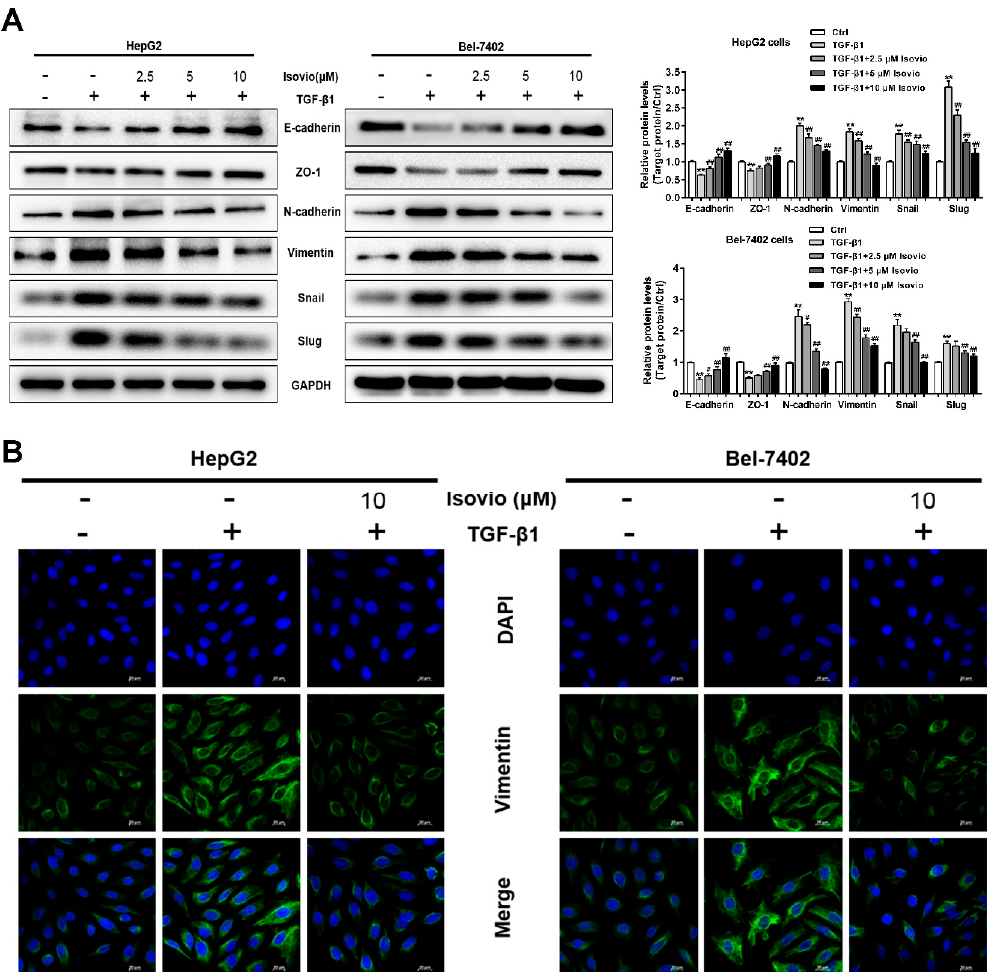
Figure 5. Effects of isoviolanthin on TGF- β 1-induced epithelial–mesenchymal transition (EMT) in HCC cells. ( A ) HepG2 and Bel-7402 cells were treated with 10 ng/mL TGF- β 1 for 48 h, during which the indicated concentrations of isoviolanthin were added for the last 24 h. The expression of the EMT markers E-cadherin, ZO-1, N-cadherin, vimentin, Snail, and Slug was assessed by Western blotting. GAPDH was used as a loading control. ( B ) E-cadherin and vimentin expression in HCC cells was determined by confocal microscopy. Green fluorescence indicates E-cadherin- and vimentin-positive expression, and blue fluorescence indicates 4’,6-diamidino-2-phenylindole (DAPI)-labeled nuclei. Scale bars: 20 µm. Representative images and bar graphs (mean ± SD) are shown, n = 3. ** p < 0.01 versus the control group; # p < 0.05, ## p < 0.01 versus the TGF- β 1 group.